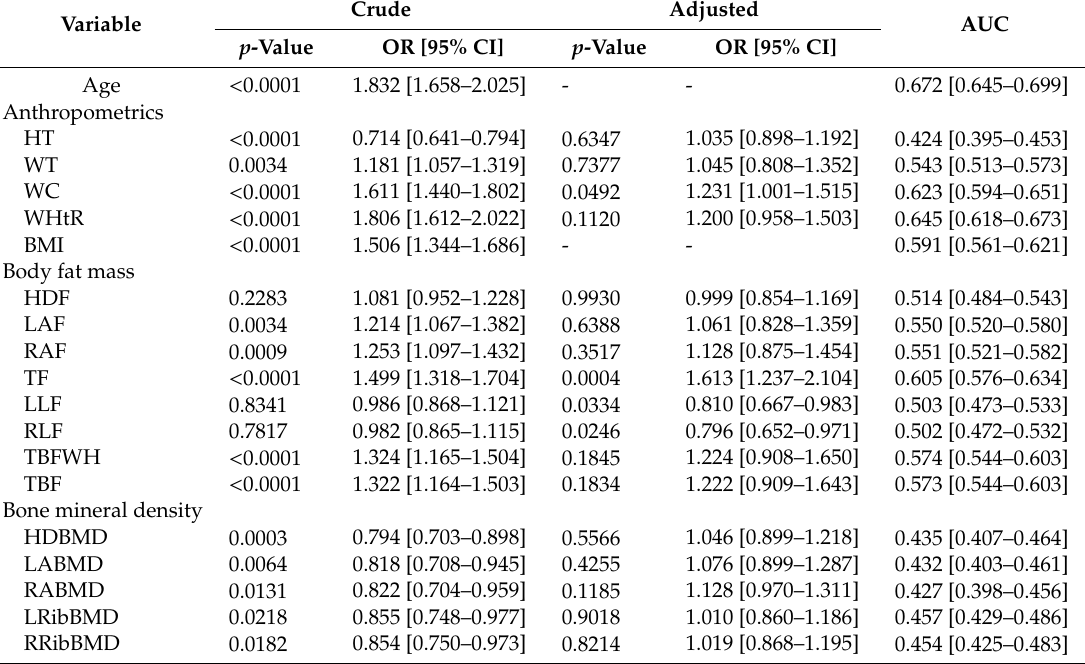
Table 4. Associations of hypertension with anthropometric and body composition indices in